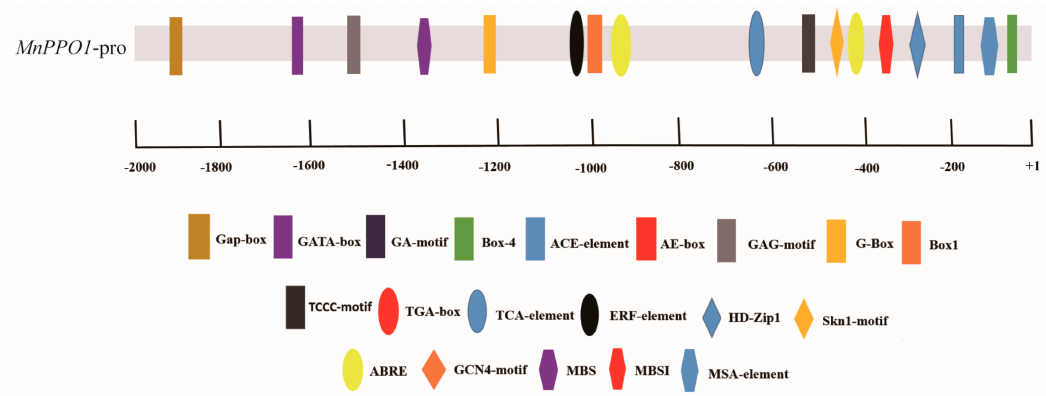
Figure 1. Transcriptional regulatory elements upstream of polyphenol oxidase 1 gene (MnPPO1) . The axis represents the + 1 to − 2000 bp sequence starting from the translation start site. Rectangles represent light-responsive elements, ellipses represent hormone responsive elements, hexagons represent the MYB transcription factor-binding elements and the MYB3R-binding cis -element (MSA), and diamonds represent other elements.